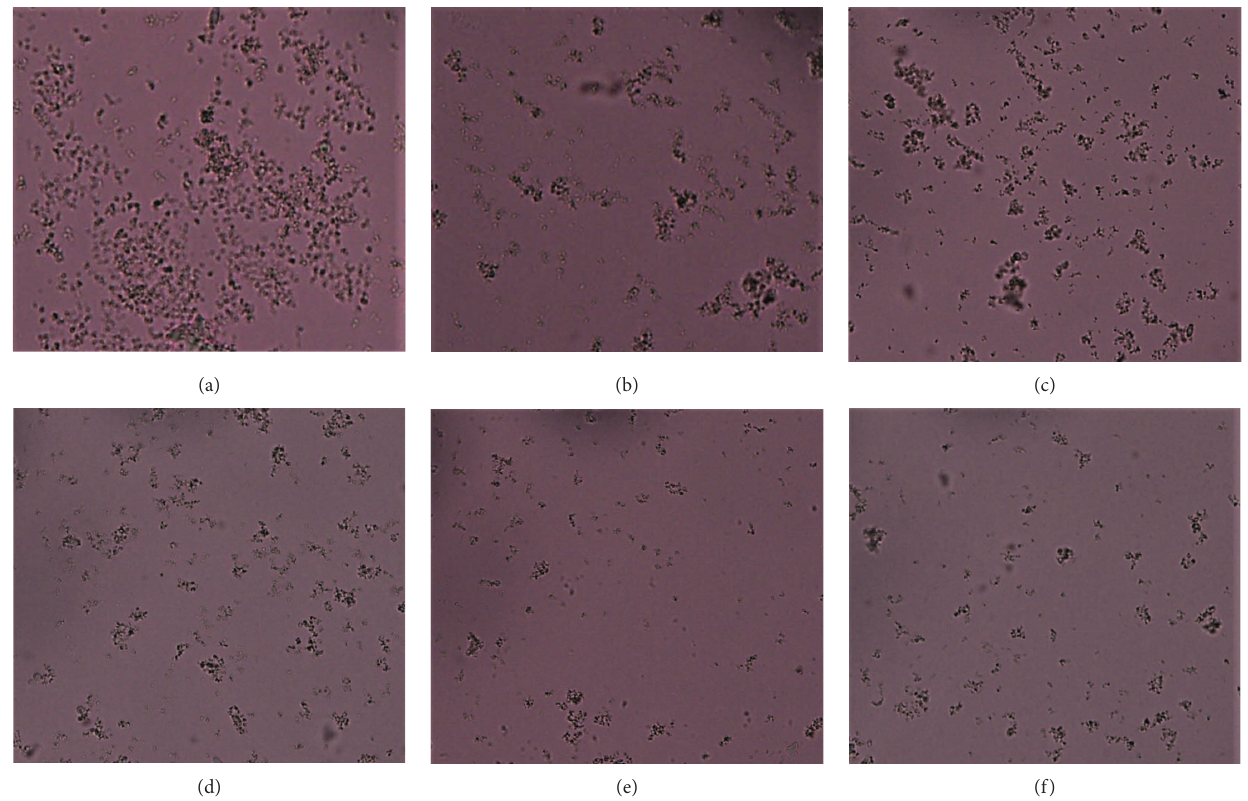
Figure 5: Representative micrographs of calcium oxalate crystals in the aggregation assay as observed under light microscope (x40 objective) in the absence of plant extracts (a), the CaOx crystals in aggregation assay in the presence of ethanol extract of Aegle